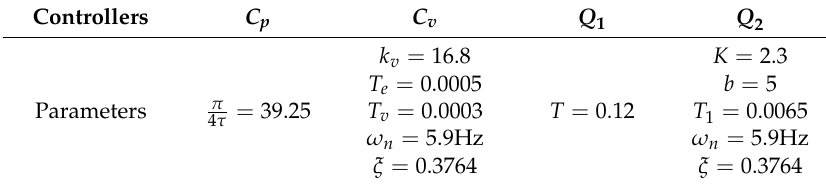
Table 1. The parameters of controllers. When EOB is added, C p should be changed to C (cid:48) p = 0.8 C p for sufficient PM and GM according to the previous